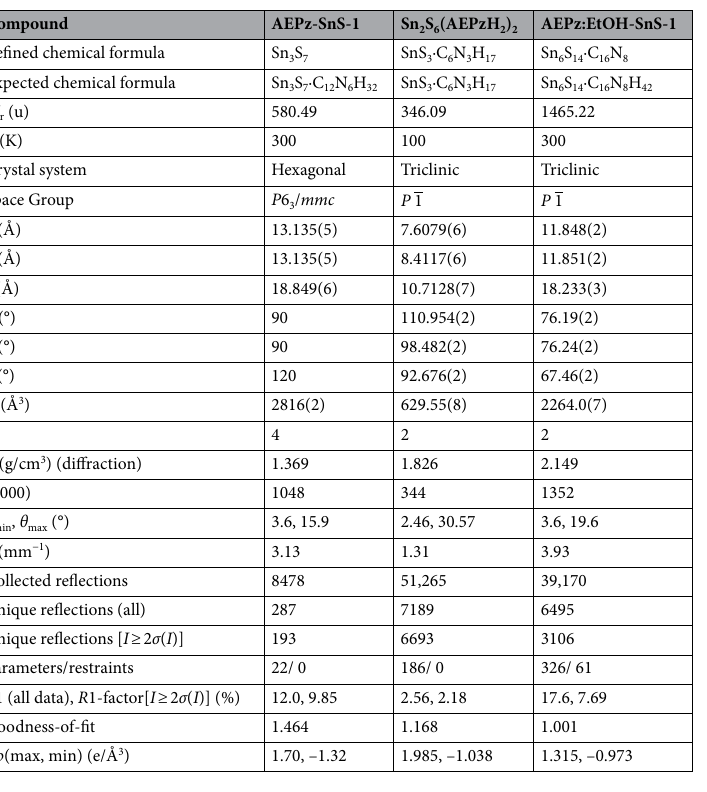
Table 1. Crystallographic data for the three thiostannates. The Refined chemical formula (entry 1) refers to the composition as determined by single crystal diffraction, whereas the Expected chemical formula (entry 2) gives the materials composition based on combined single crystal diffraction analysis and elemental analysis/ hydrogen